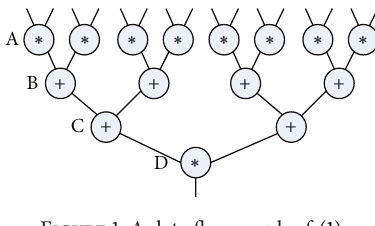
Figure 1: A data flow graph of (1).